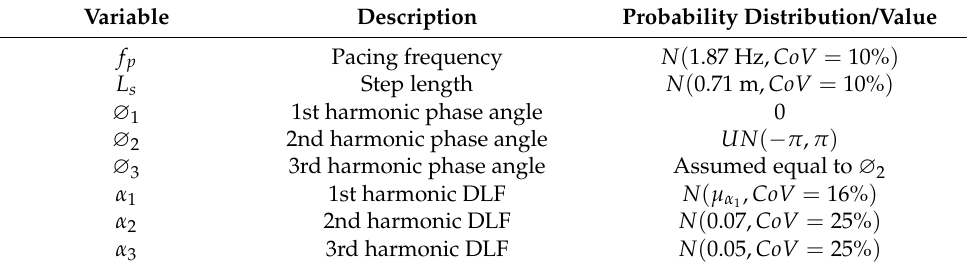
Table 1. Summary of the inter-subjective variabilities.